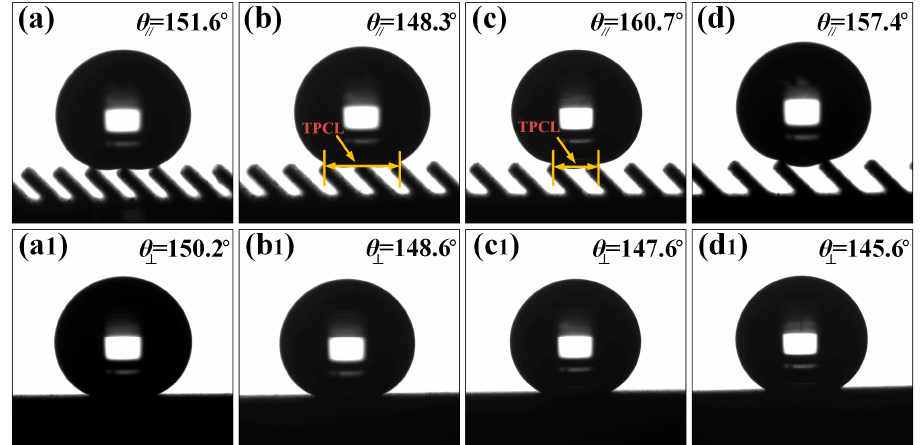
Figure 5. The contact angles of water droplets in the parallel and perpendicular directions at different L of inclined groove ( A = 45°): the direction parallel to groove ( a ) L = 200 µm, ( b ) L = 250 µm, ( c ) L = 300 µm, ( d ) L = 350 µm; the direction perpendicular to groove ( a1 ) L = 200 µm, ( b1 ) L = 250 µm, ( c 1 ) L = 300 µm, ( d1 ) L = 350 µm.